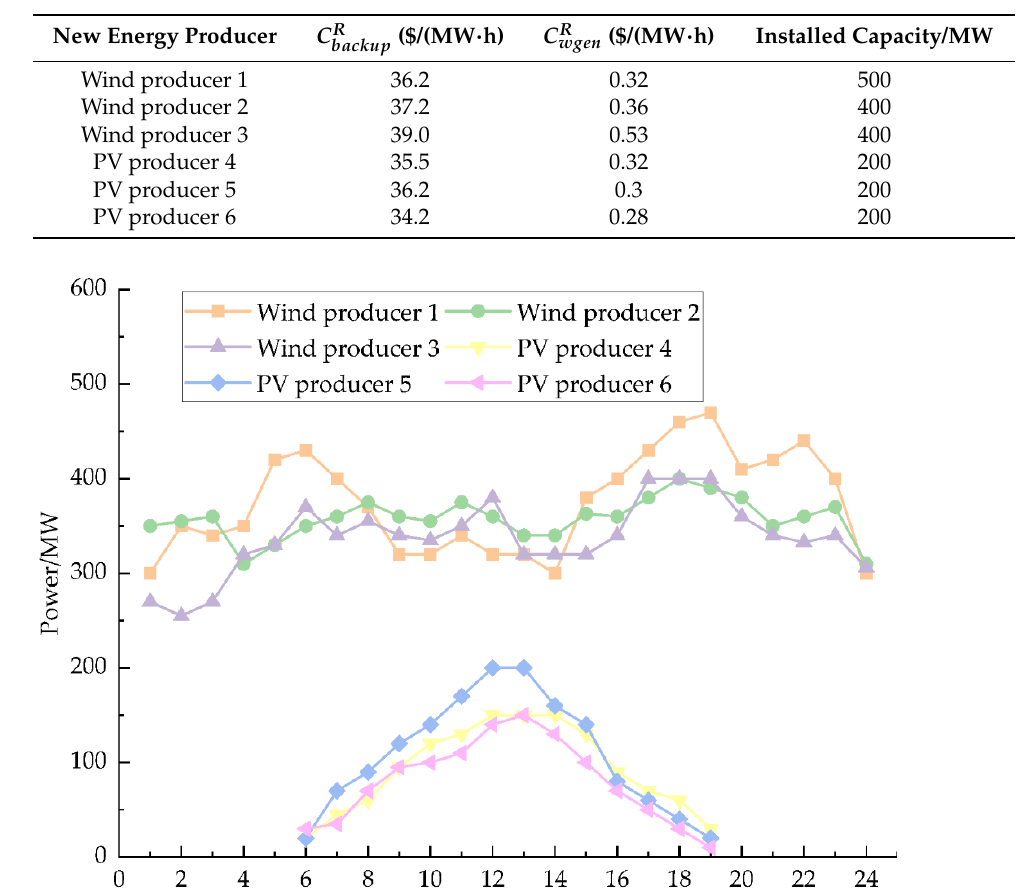
Table 2. Quotation factor for wind producer 1.